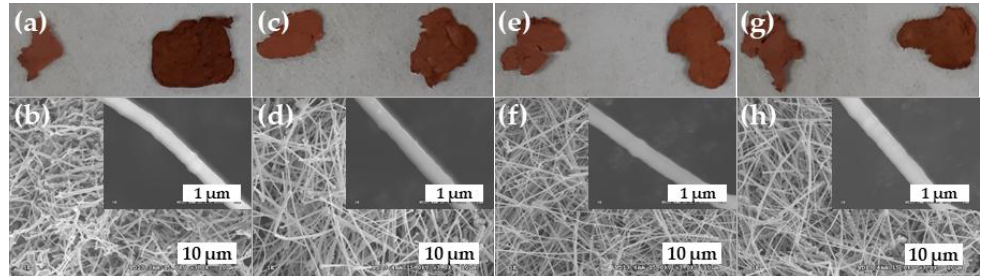
Figure 3. ( a , c , e , g ) Optical images of G/Cu-NW specimens before and after oxidation (specimens on left and right of each image, respectively), and ( b , d , f , h ) SEM images of G/Cu-NWs for CH 4 concentrations of ( a , b ) 10, ( c , d ) 20, ( e , f ) 30, and ( g , h ) 40 sccm.